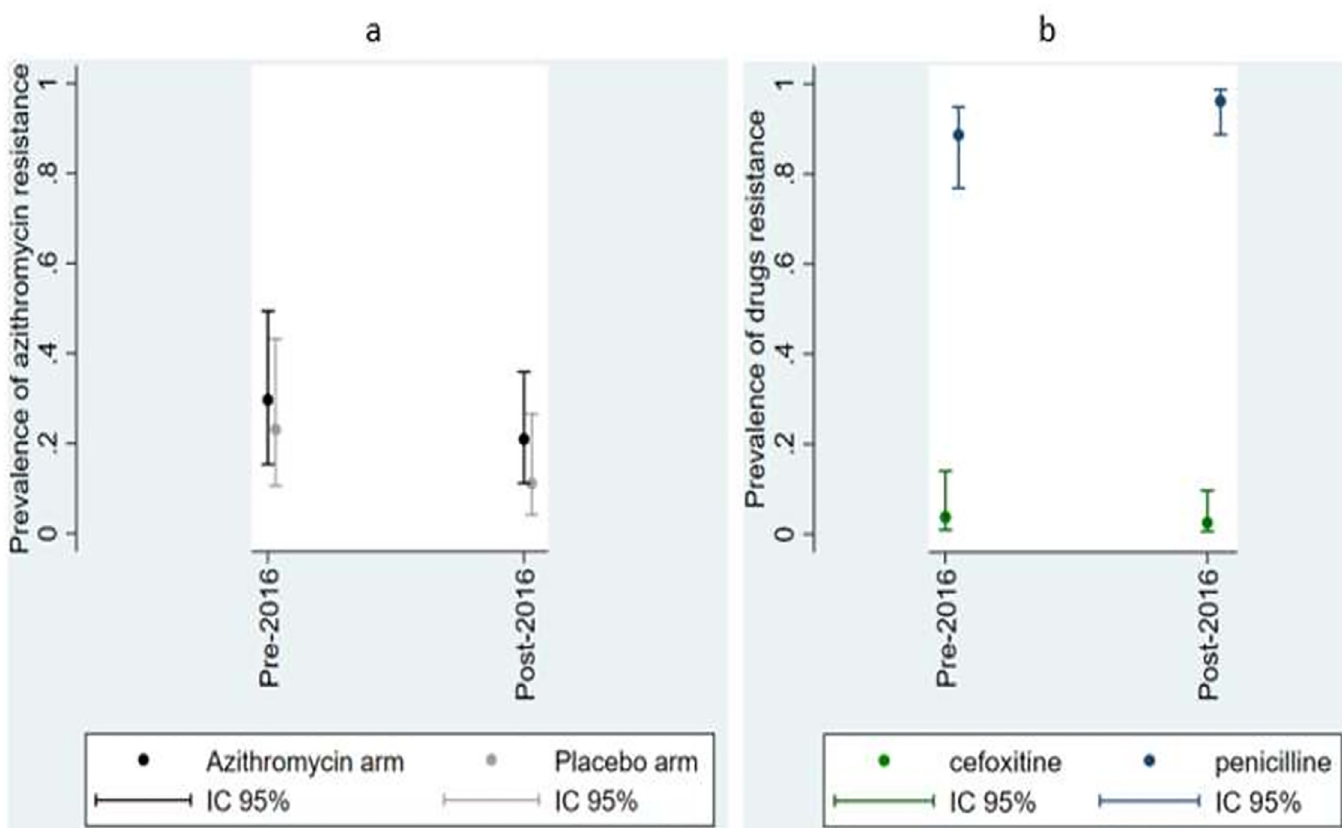
Fig 2. Prevalence of S . aureus resistance to antibiotic: a) Resistance to azithromycin by arm before and after intervention; b) resistance to penicillin and cefoxitin before and after administration of azithromycin.